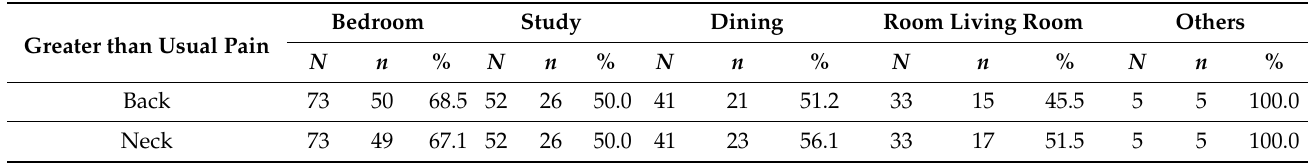
Table 1. Perception of ailments by telework